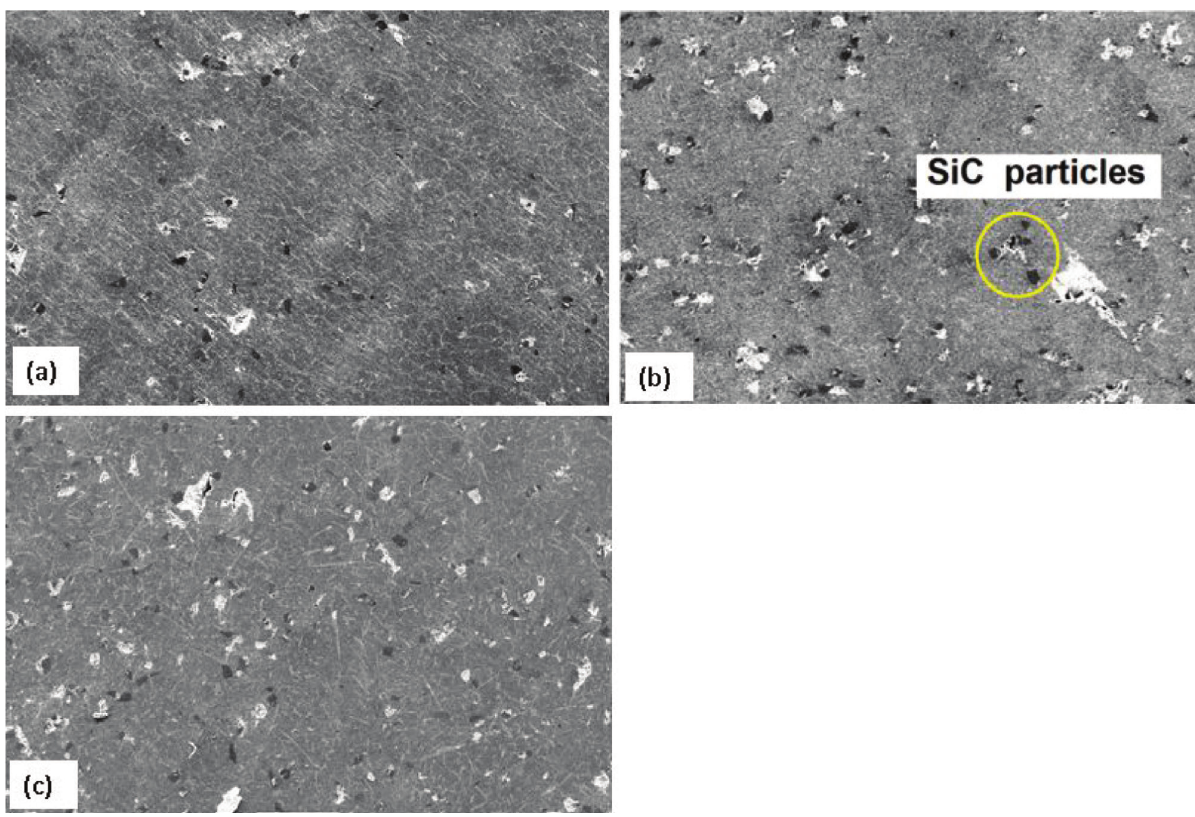
Fig. 6: SEM images of microstructures of the composites (a) 3%, (b) 6% and (c) 12%